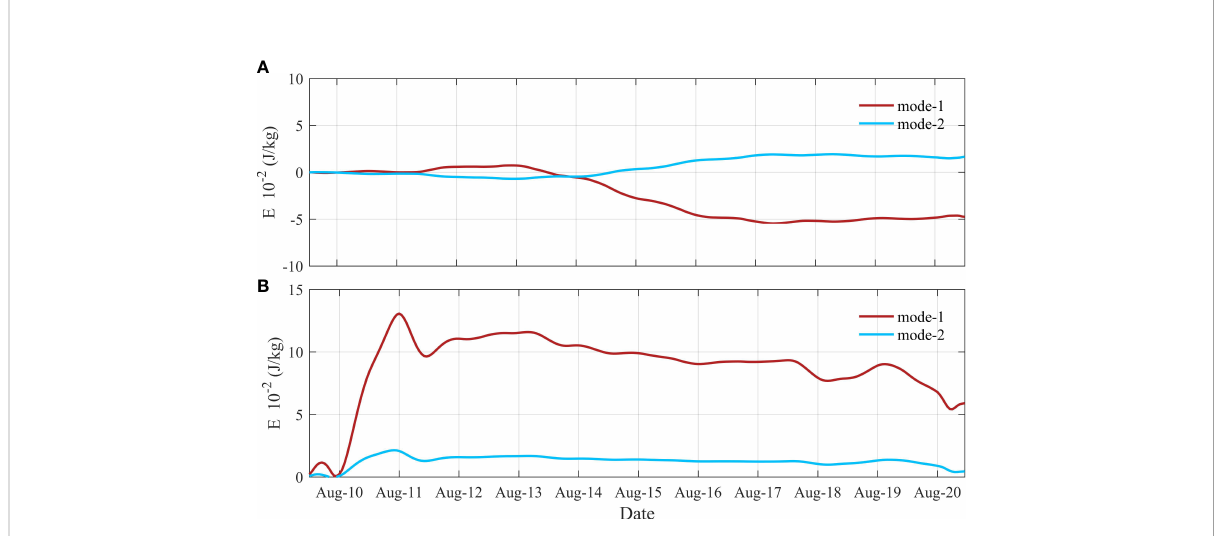
FIGURE 8 Energy (J/kg) gain and loss of each mode from (A) the bottom friction and (B) wind at the mooring site. The red and blue lines represent the fi rst and second mode energy, respectively.